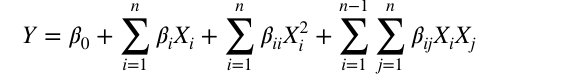
Table 1 Experimental range and levels of the independent variables for AB25 adsorption